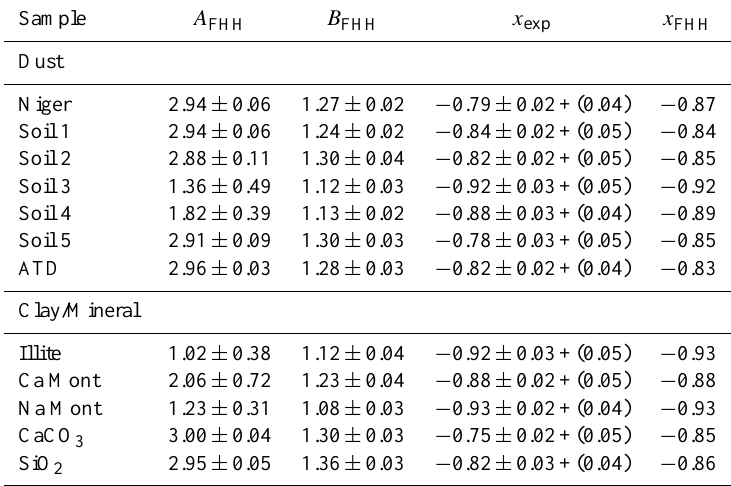
Table 2. FHH parameters and exponent comparisons for different regional dusts and individual clays/minerals. Sample